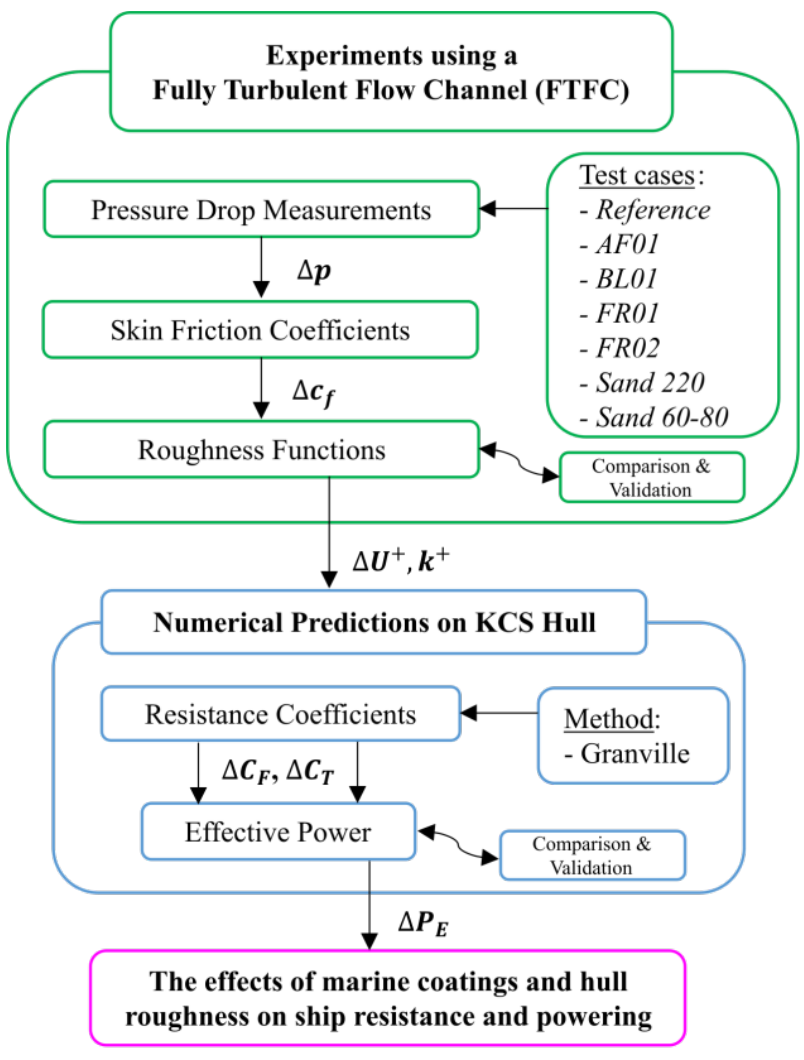
Figure 1. Schematic illustration of the methodology adopted.